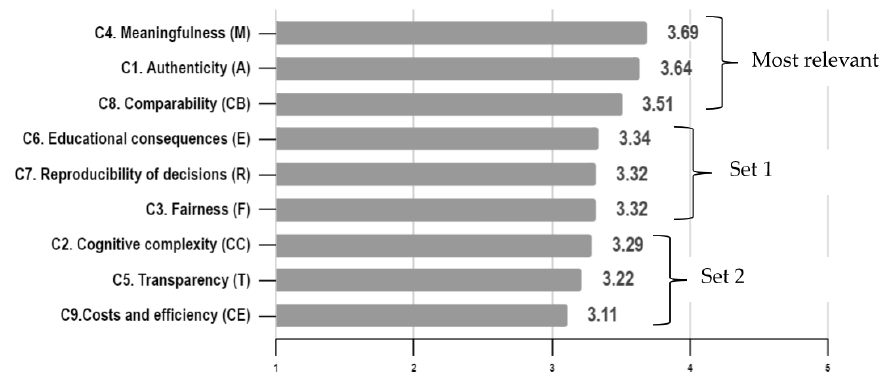
Figure 1. Scores achieved on every criterion of the CRISS CAM. (mean on a 1–5 scale, n [teachers]: